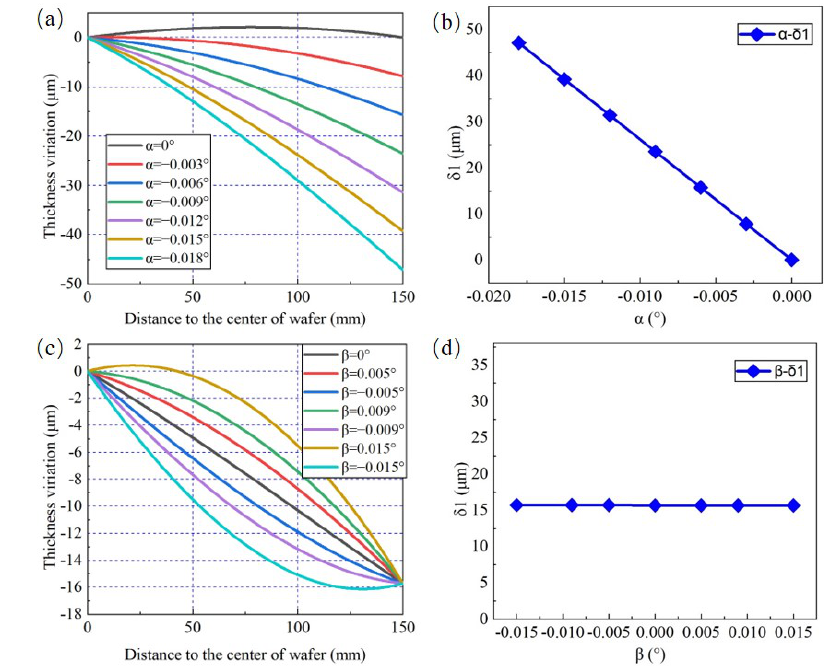
Figure 6. The change rules of δ 1 affected by space angles. Effect of ( a ) α on the thickness variation ( β = 0.006°); ( b ) α on δ 1 ; ( c ) β on the thickness variation ( α = − 0.006°); ( d ) β on δ 1 .